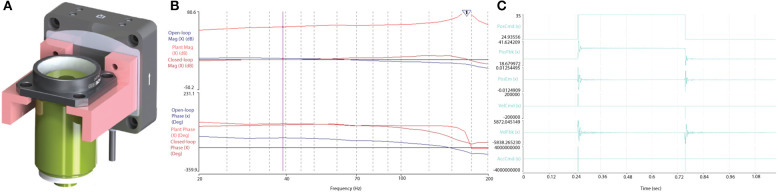
Optical train and piezoactuator performance validation. (A) The 0.176 Kg objective assembly mounted on the Aerotech, piezo actuator, and (B) the Bode plot output following a stability test proved the actuator stable up to ~125 Hz. (C) The Z-stage, piezo actuator's response to a step command over 100 and 10 μm, respectively. The Piezo achieved a maximum velocity of 0.043 m/s with a following error less than ± 5 × 10−6 m, and a settling time of <5.3 × 10−3 s.